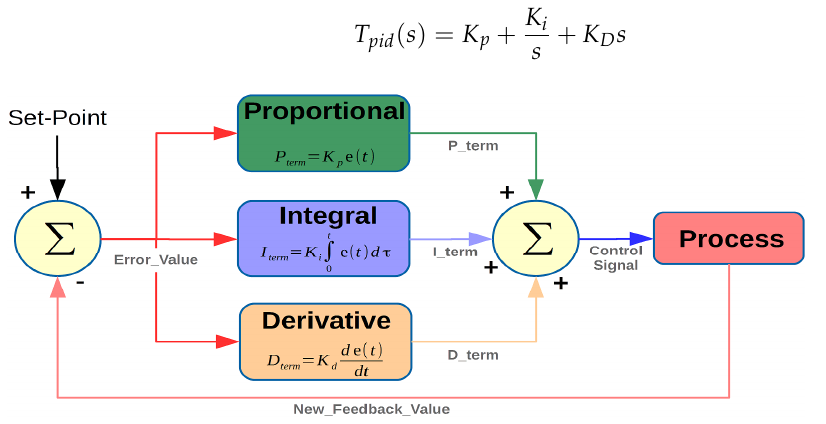
Figure 6. PID control scheme.